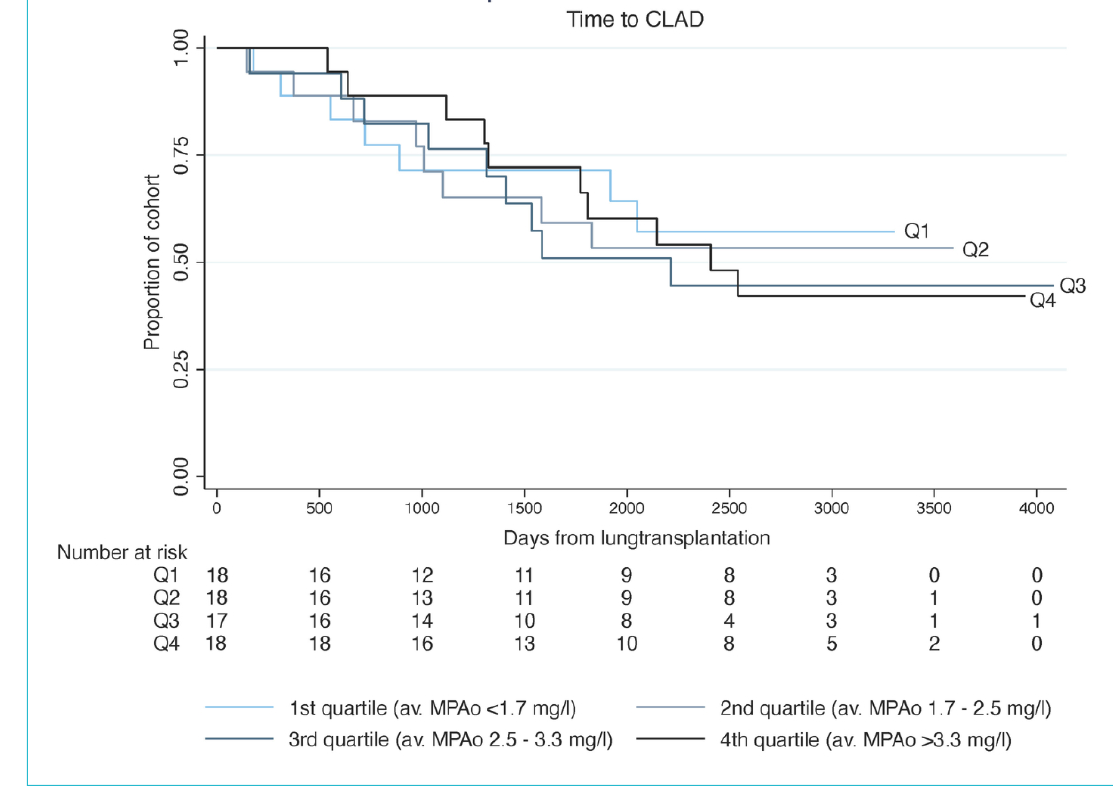
Figure 2: Kaplan-Meier graph failure estimate Q. Almost 50% of the patients developed chronic lung allograft dysfunction by the fifth post- transplant year (i.e., after 1826 days). CLAD: chronic lung allograft dysfunction; MPA 0 : trough concentration of mycophenolic